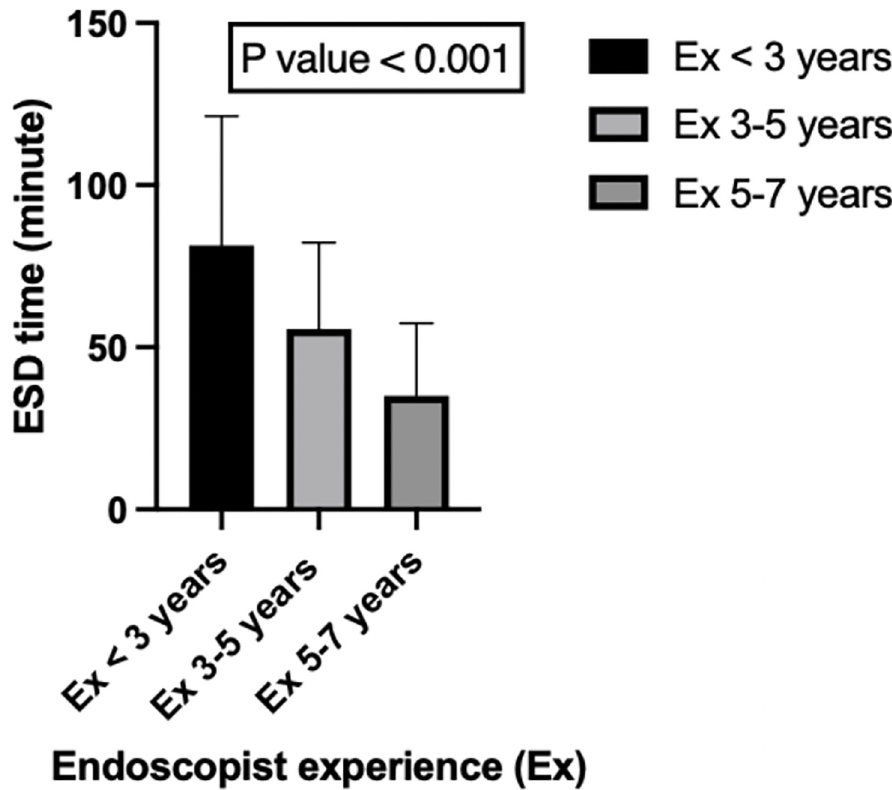
Fig 2. Analysis of ESD time according to endoscopist’s